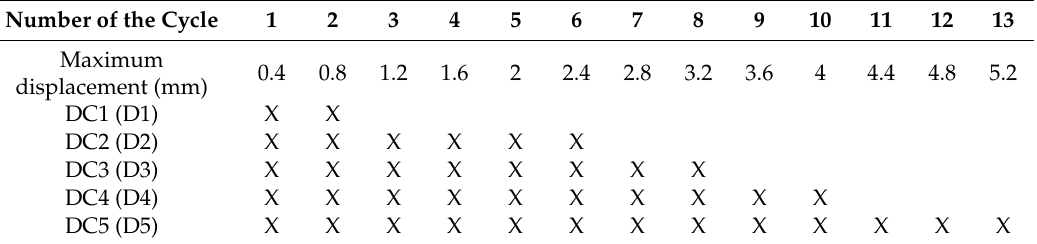
Figure 8. Load patterns applied to specimens DC1 to DC5. Table 1. Number of the cycle and maximum displacement reached.